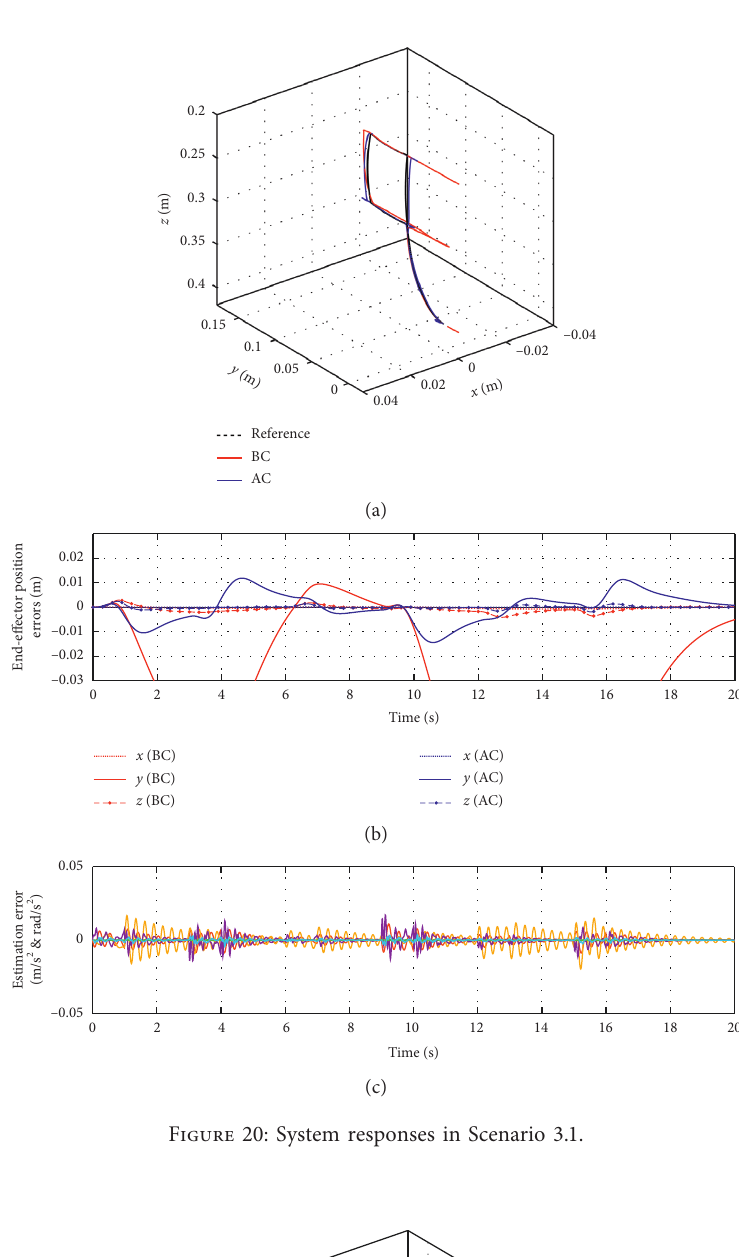
Figure 20: System responses in Scenario 3.1.